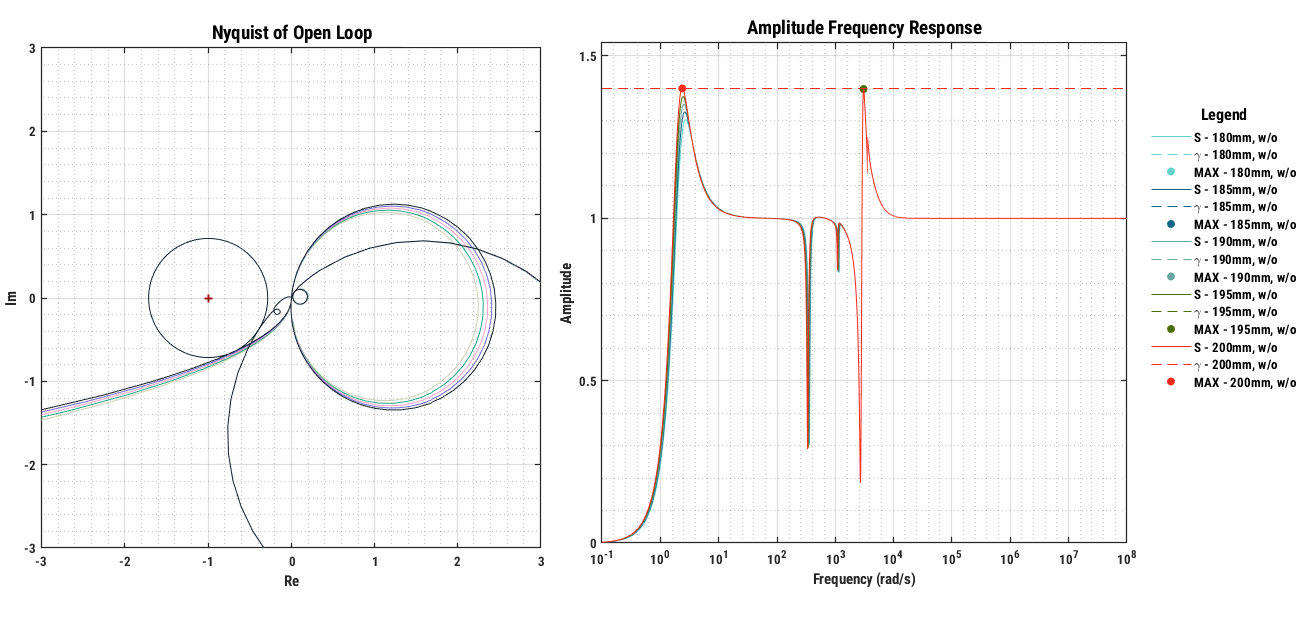
Figure 21. Validation of the design requirements: plots of open-loop Nyquist L k ( j ω ) ( left ) and closed-loop Bode for sensitivity function S k ( j ω ) ( right ) under assumed plant